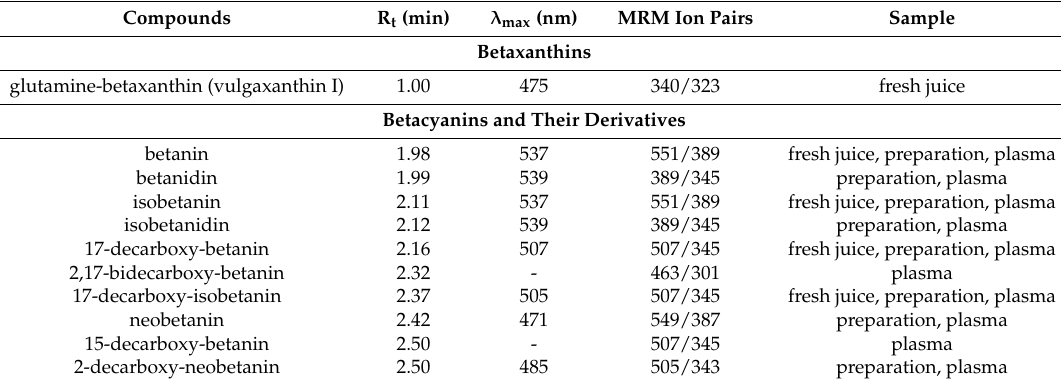
Table 3. Betalains identified in fresh juice, preparation, and plasma. Compounds R t (min) λ max (nm) MRM Ion Pairs